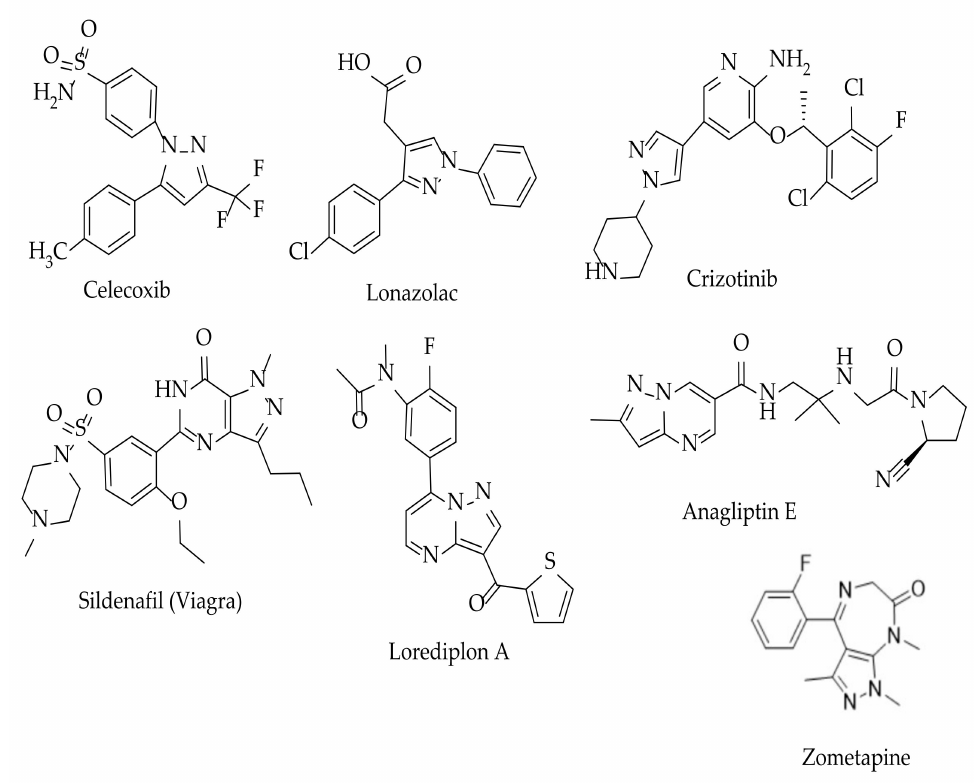
Figure 2. Structure of drugs bearing the pyrazole moiety.